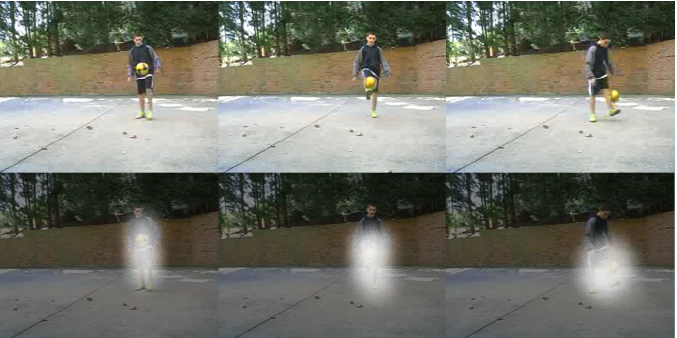
Figure 1. Original image ( top ), image with visual attention applied ( bottom ). The area marked in white has a high attention